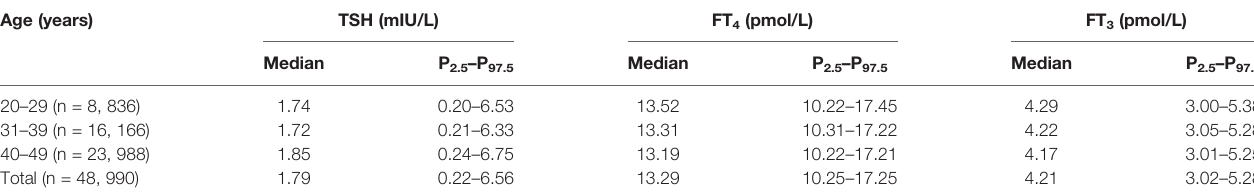
TABLE 2 | Distribution of TSH, FT 4 , and FT 3 by age group.